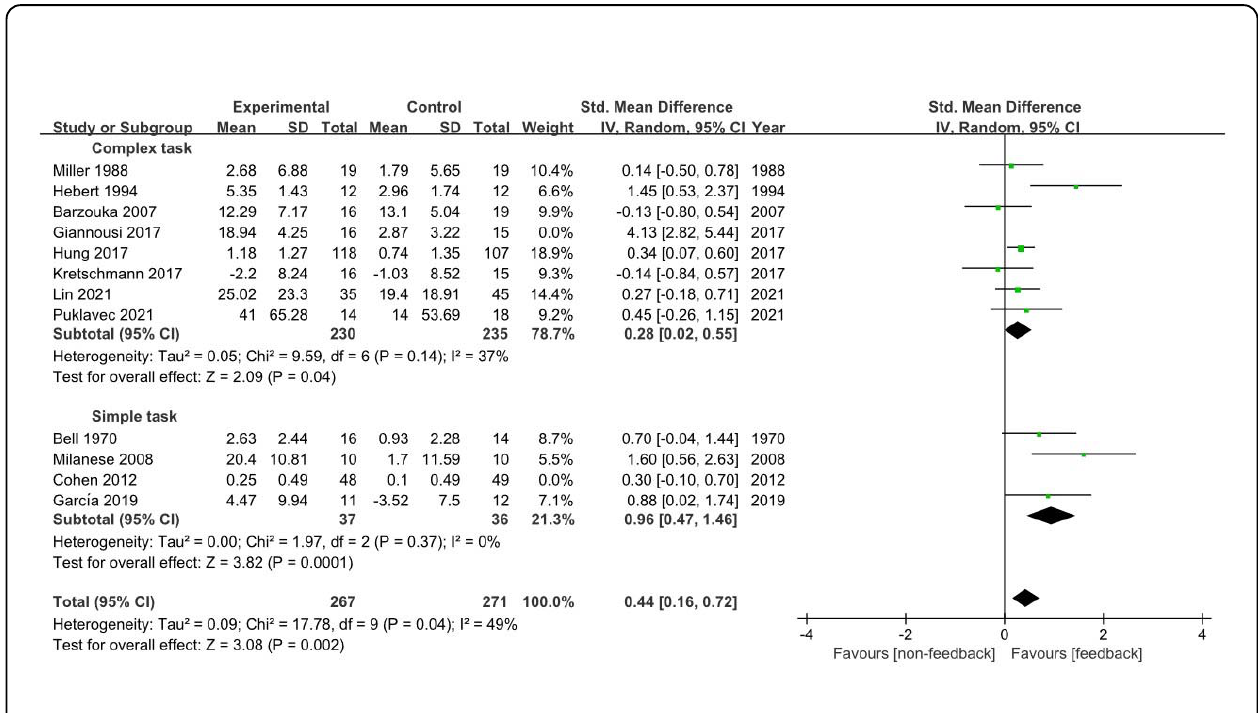
Figure 4. Heterogeneity analysis. The first and second black diamond represents the effect estimate of the meta-analysis of the complex task group and simple task group respectively, and the third black diamond represents the overall effect estimate of the meta-analysis; the green box represents the point estimate of the effect for a single study. Studies for complex task group are Miller (1988) [36],